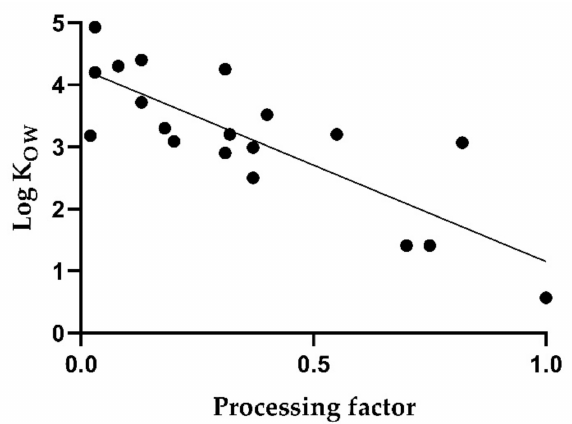
Figure 4. Correlation of median processing factors with octanol-water partition coefficients of pesticide active substances for red wines. Each dot represents one of the pesticides in Table